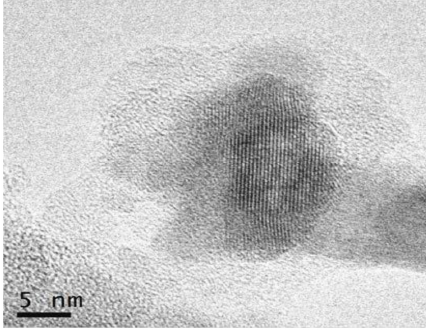
Figure 17. HRTEM of 80SiO 2 -20GdF 3 self-supported layer treated at 550 °C for 1 min. FTIR spectra of 80SiO 2 -20GdF 3 xerogel and GC treated at 550 °C for 1 min are shown in Figure 18. Similar results are obtained with respect to the 80SiO 2 -20LaF 3 composition given in Figure 12. For